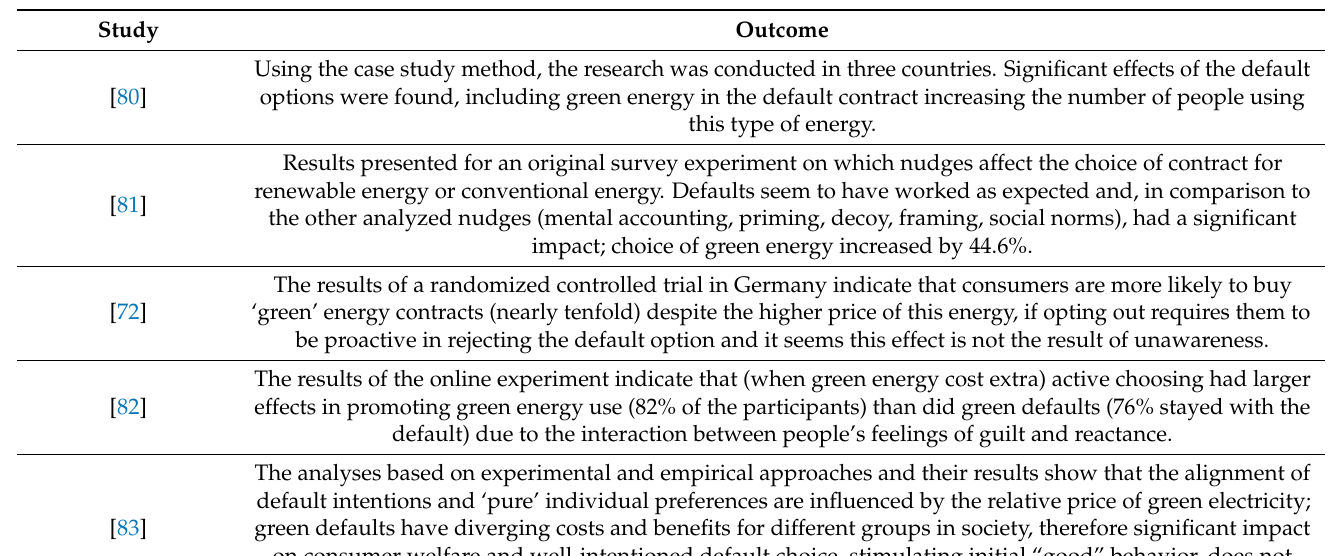
Table 2. Studies focused on the analysis of the impact of green defaults on the choice of green energy (in time